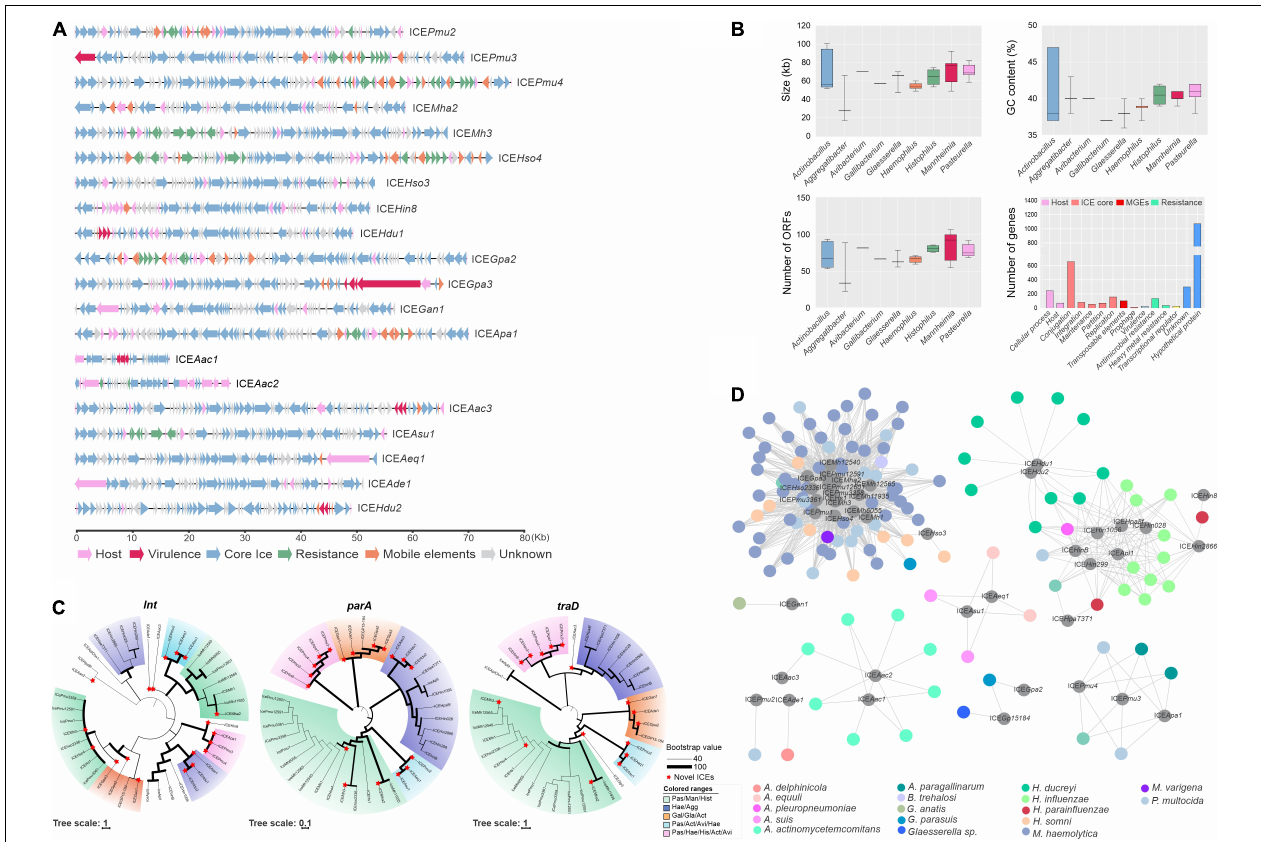
FIGURE 4 | Heterogeneous groups of integrative and conjugative elements (ICEs). (A) Representation of novel ICEs found integrated into Pasteurellaceae genomes. ICE size is indicated in the scale bar (in kilobases) and ORF functions are represented by arrows colored below the figure. (B) General overview of reported and novel ICEs of the family grouped by genus according to ICE size (top-left graph), GC content (top-right graph), ORF content (bottom-left graph), and gene function (bottom-right graph). (C) The evolutionary history of integrase ( int ), topoisomerase ( parA ), and coupling protein ( traD ) genes from ICEs inferred by using the Maximum Likelihood method based on the General Time Reversible model. The tree is drawn to scale, with branch lengths in the same units as those of the evolutionary distances used to infer the phylogenetic tree. Colored clusters represent conserved species groups among the trees. Bootstrap values are represented by the line thickness (see legend in the figure). (D) Network dispersion analysis of the ICEs among the Pasteurellaceae species (host genomes) represented in the species group. ICEs are displayed in dark gray circles with respective names.